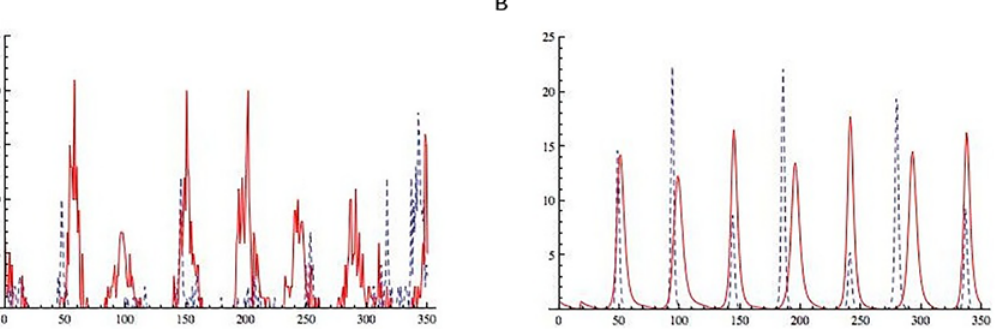
Fig 10. Real data and numerical simulations. RSV is plotted with a continuous line; influenza cases plotted with a dashed line. (A) RSV and influenza cases from SLP data. (B) RSV and influenza cases from model output. Horizontal axis is time in days; vertical axis is proportion of the population. Plot is shown after a transient time of 5000 days with arbitrary initial condition and parameters σ = 0.7, b 1 = 0.9162 and b 2 = 0.4566 and θ = 0.0001 for R 01 = 1.83 and R 02 =